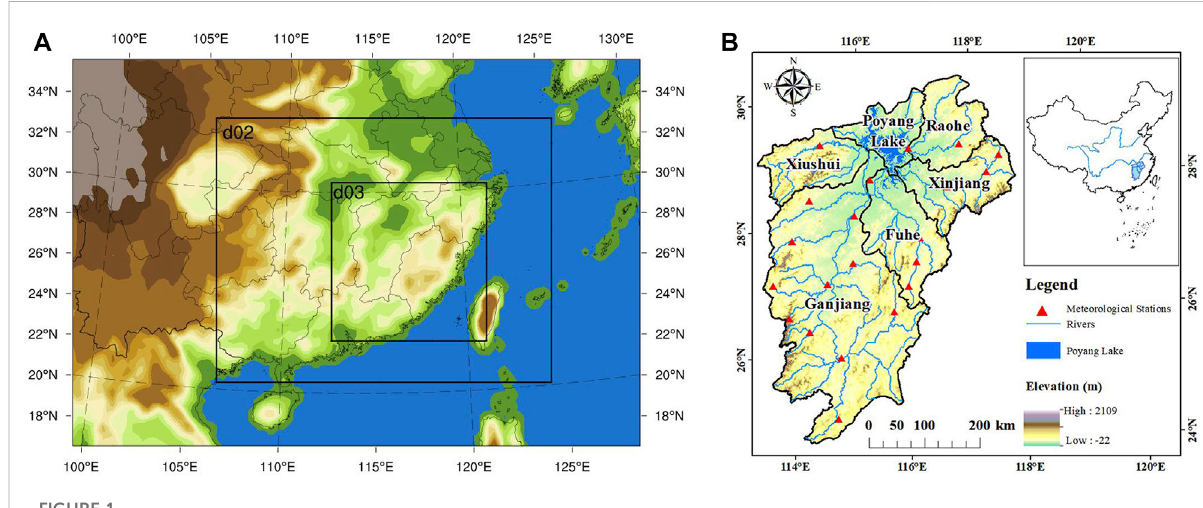
FIGURE 1 Locationofstudyarea. (A) WRFmodeldomains withthreegrids(d01-27,d02-9,d03-3 km). (B) TopographicfeaturesofthePoyang LakeBasin,